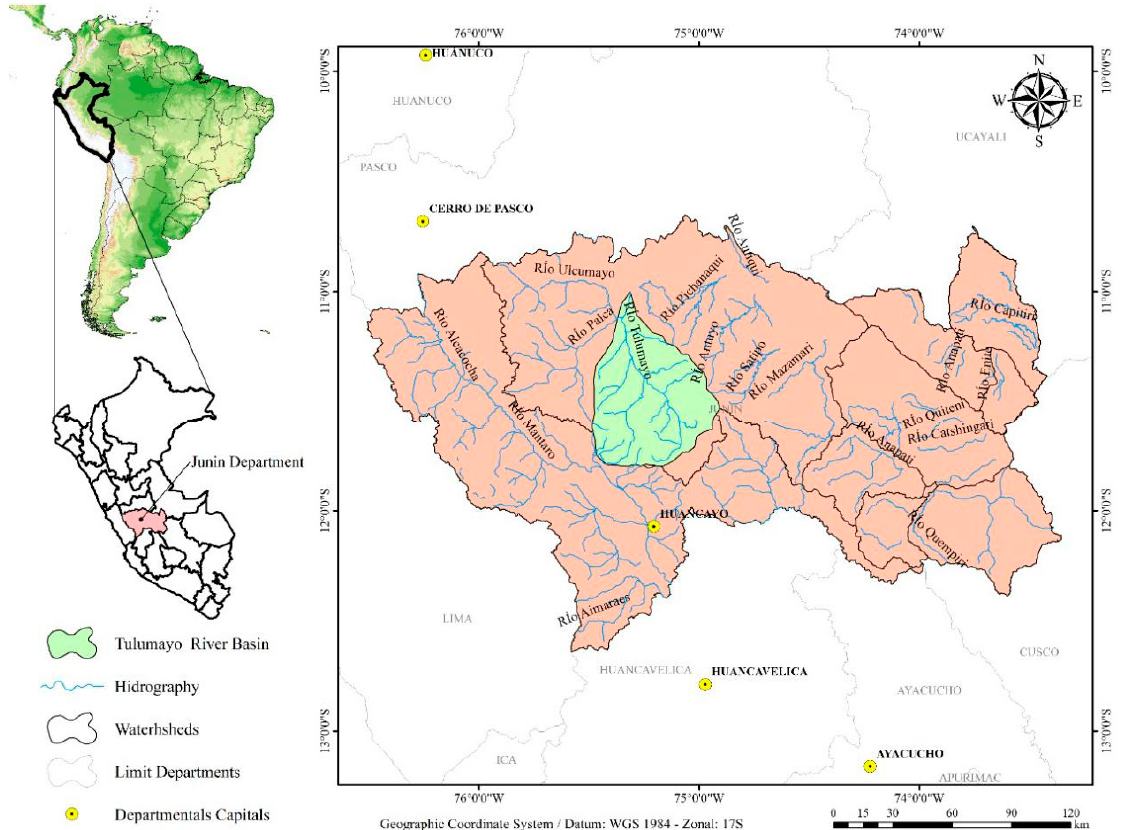
Figure 1. Location of the Tulumayo River Basin, Junin Department in the Peruvian Central Andes. Elaboration: Luciano Cavalcante de Jesus França. Source: GEO GPS PERÚ [38].